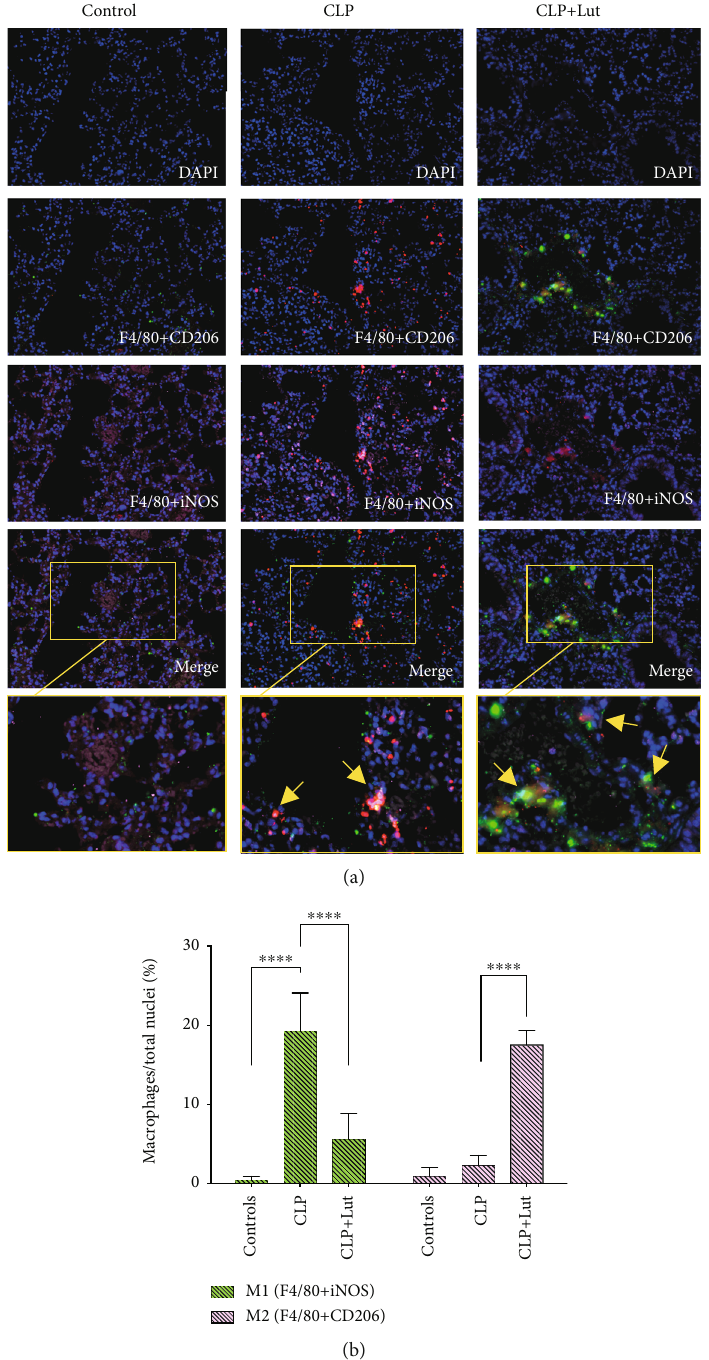
Figure 3: Treatment with luteolin regulates M1 and M2 macrophage phenotypes in lungs of CLP mice. (a) Treatment with luteolin reduces the proportion of M1 macrophages, while increasing the proportion of M2 macrophages in lungs of CLP mice, hence playing a protective role in ALI. The proportion of pink fl uorescent iNOS expressing M1 macrophages increased signi fi cantly, while lungs of CLP mice were substantially negative for green fl uorescent CD206 + M2 macrophages. Treatment with luteolin reduced the proportion of M1 while increasing that of M2 macrophages in ALI. Five 400x fi elds of positive cells were counted and analyzed. Each group n = 5 , experiments are repeatable, and the most representative one was shown. Data of the column graphs are presented as means ± SD . ∗∗∗∗ p < 0 : 0001 by the one-way ANOVA followed by LSD multiple comparison test, compared between the control, CLP, and CLP+Lut